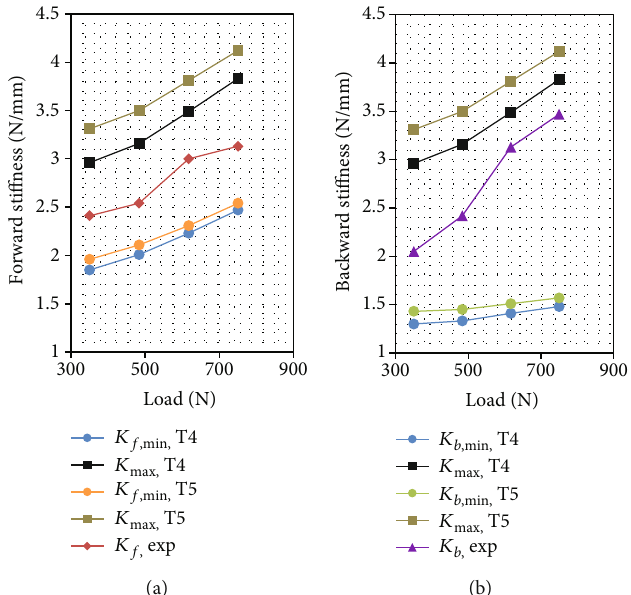
Figure 3: Bracketing of (a) forward and (b) backward trunk sti ff ness with respect to the load for tonus levels T4 (15%, 28%, and 32%) and T5 (15%, 28%, and 40%) for classes C1, C2, and C3,